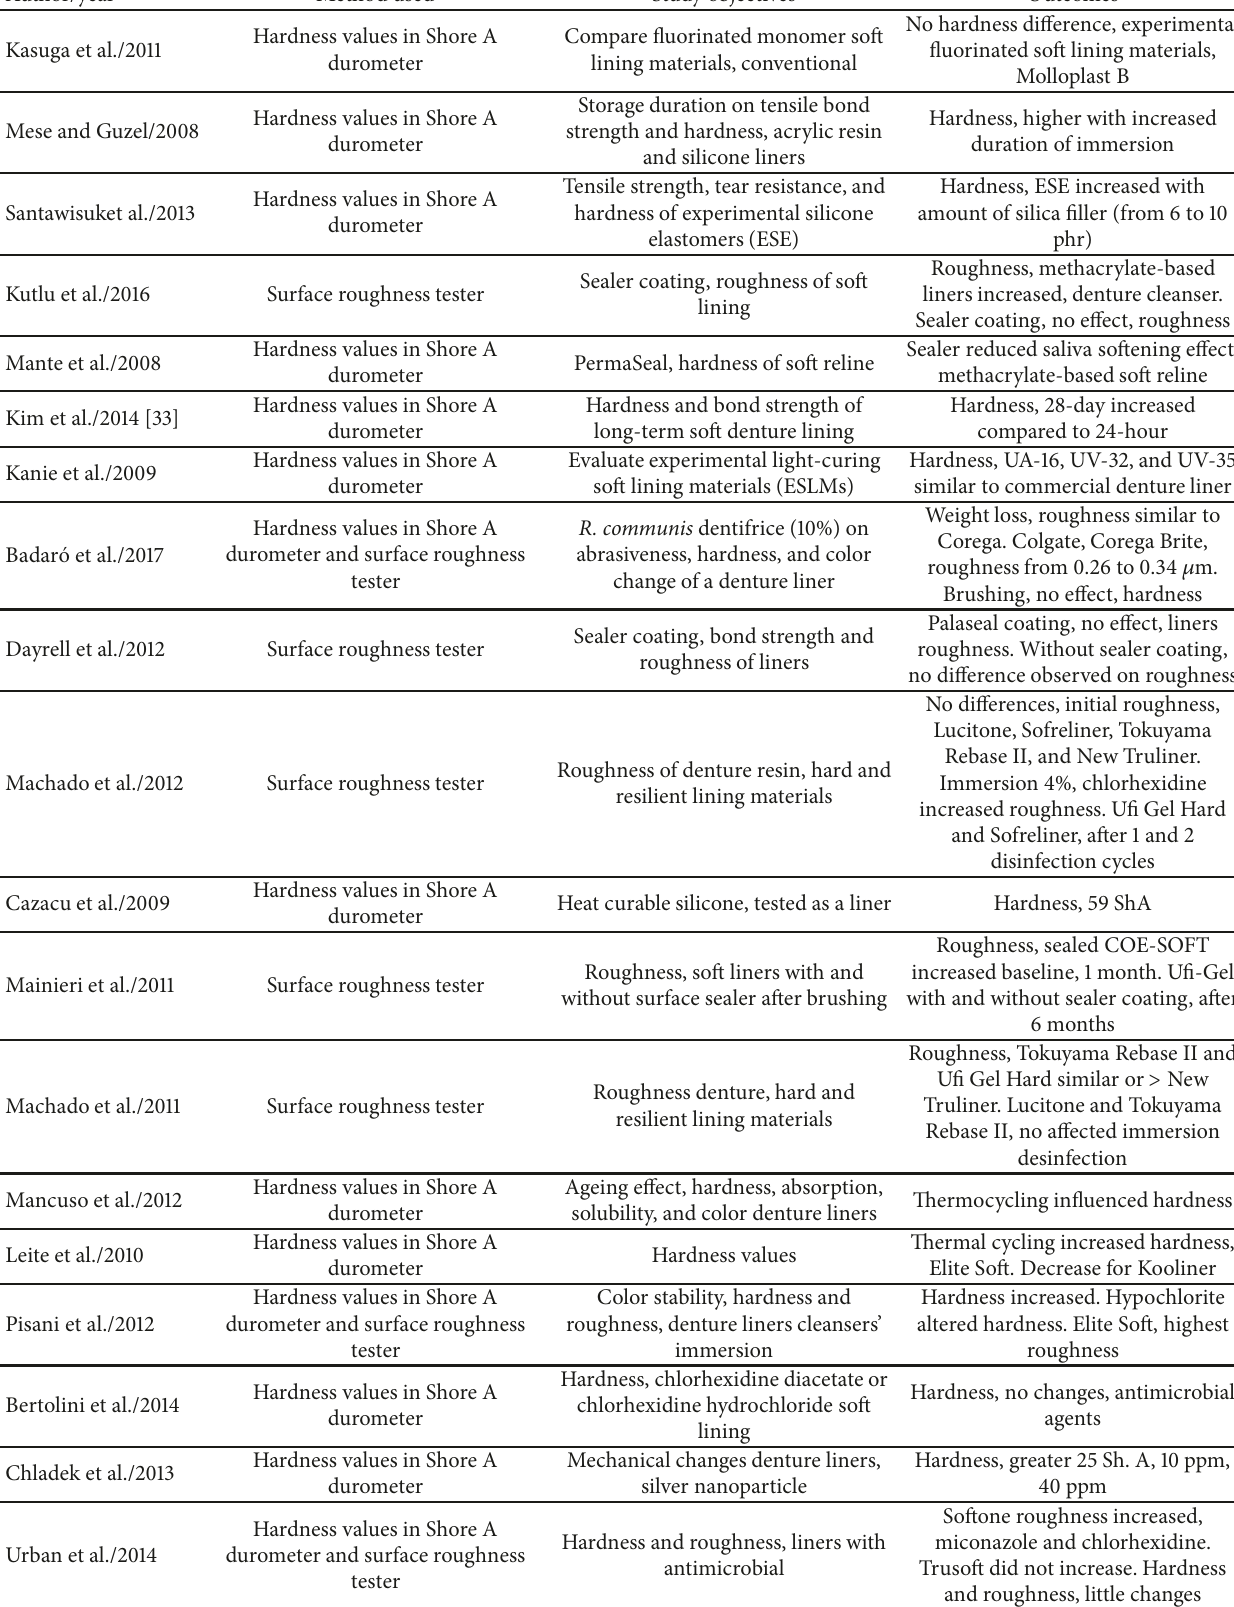
Table 2: Included studies related to the hardness and roughness for soft denture